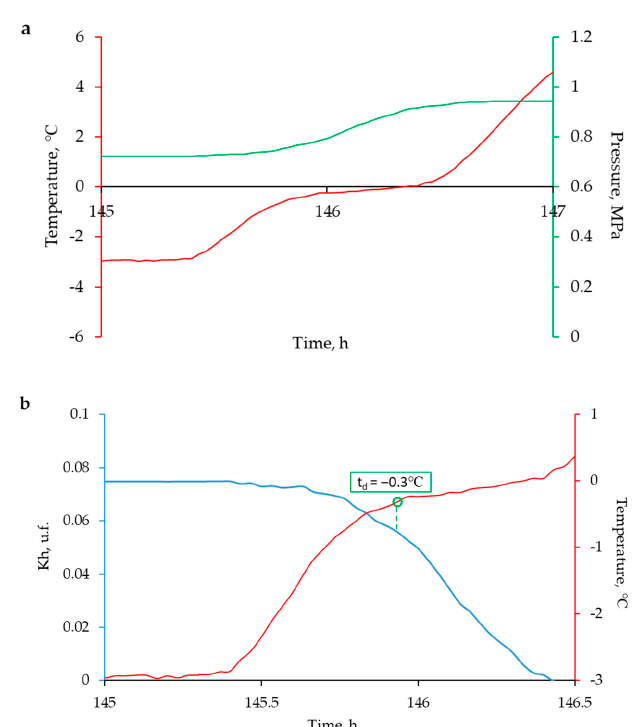
Figure 2. Time-dependent change of temperature and pressure ( a ), and hydrate coefficient ( Kh ) ( b ) in frozen hydrate-bearing sand exposed to warming. t d is the temperature corresponding to the onset of rapid pore hydrate dissociation.